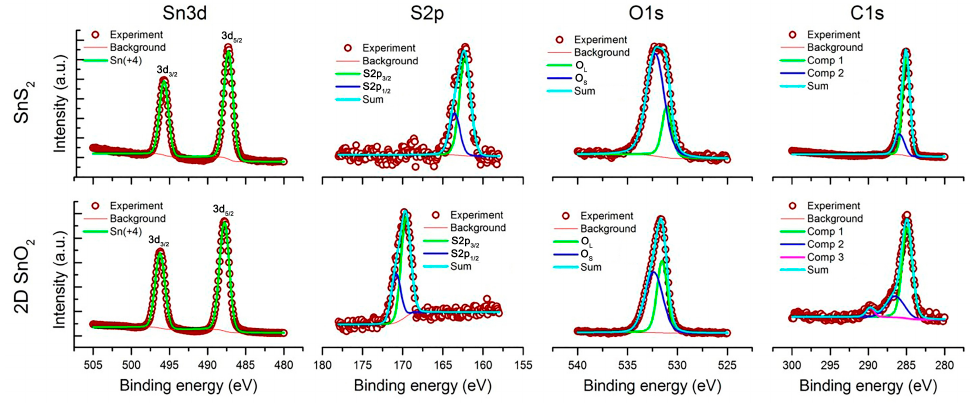
Figure 7. XP-spectra of SnS 2 and 2D SnO 2 .